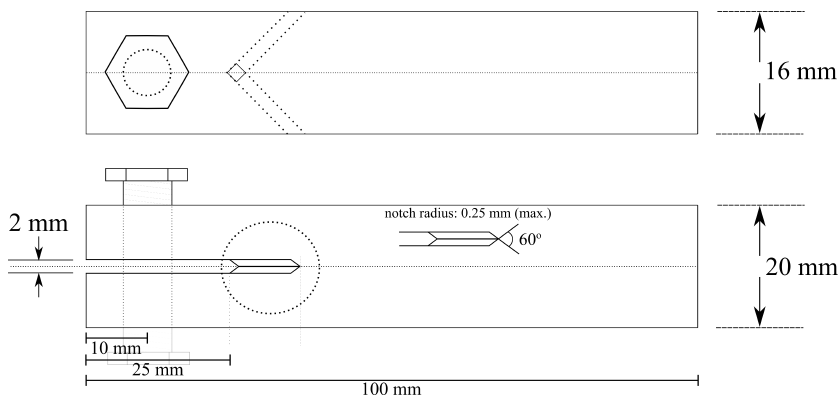
Figure 1. Schematic drawing of the DCB specimens used in this